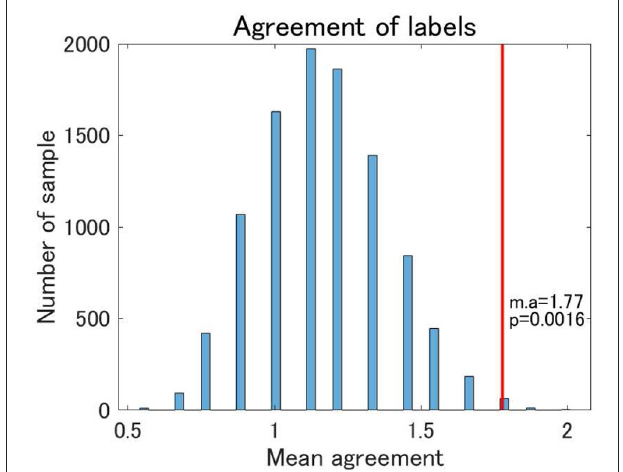
FIGURE 7 | Agreement of cluster labels of traveling subjects (TS) between UTO scanner and KYO-A scanner. The agreement was measured as follows: each traveling subject performed three repetitions of fMRI scans for both the UTO scanner and KYO-A scanner. For each scan, we evaluated the FC matrix, which was subsequently used for classification based on the estimated model of view 4. Next, we evaluated the number of scans out of the three agreements between UTO and KYO-A (minimum 0; maximum 3). Finally, we took the average of the agreement for all traveling subjects (nine subjects). The null distribution of agreement is shown in the bar chart, which is based on 10,000 randomly shuffled TS data. The red line denotes the observed value of the mean agreement (the observed mean agreement and p -value are displayed on the right). Note that the correlation matrices are whitened by the corresponding